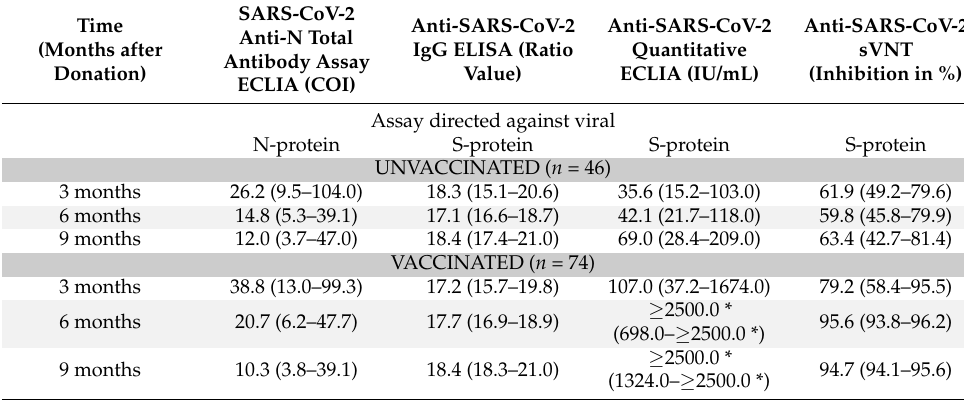
Figure 3. SARS-CoV-2 anti-N total antibody levels significantly decline but are detectable one year after an infection. ( A – C ) The participants were divided into three groups according to the time of infection and time of blood donation (group 1: 0–45 days post SARS-CoV-2 infection, group 2: 3 months (3 m) +/ − 45 days post SARS-CoV-2 infection, group 3: no information about the time of infection with SARS-CoV-2 available). ( D ) Decline in anti-N total antibody levels for all 120 study participants. Data shown are cut-off indices (COI) of SARS-CoV-2 anti-N total antibodies relative to the baseline signal (=COI value of the initial donation) 3, 6 and 9 months (m) after the initial blood donation. p = p -value for time trend. Table 1. Serological examination 3, 6 and 9 months after blood donation. Four different measurements were performed: SARS-CoV-2 anti-N total antibody screening, IgG ELISA and a quantitative ECLIA (both anti-S) and a surrogate virus neutralization test (sVNT). Data shown are median values with interquartile range for unvaccinated and vaccinated study participants. * Upper limit of the dynamic range of the applied